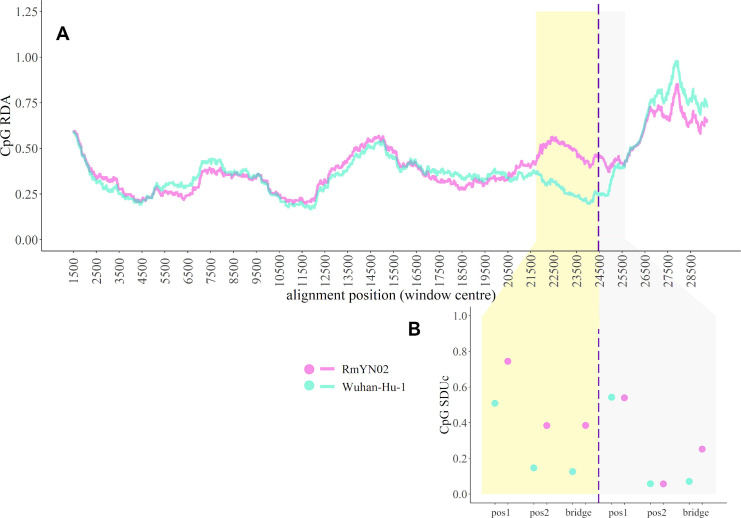
(A) 3kb sliding window plot of RDA across the whole-genome alignment of Wuhan-Hu-1 (turquoise) and RmYN02 (magenta). Shaded regions depict the Spike ORF region in the alignment. The dashed line indicates the inferred RmYN02 Spike recombination breakpoint, splitting the shaded region into non-nCoV (yellow) and nCoV (grey). (B) SDUc values calculated for each frame position of the 2 RmYN02 Spike nonrecombinant regions and the corresponding Wuhan-Hu-1 regions. The absolute differences between SDUc values of SARS-CoV-2 and RmYN02 for each frame position are significantly greater in the non-nCoV than in the nCoV region (t2.07 = 3.03, p = 0.0450; unpaired one-tailed t test with unequal variance). The list of GenBank and GISAID accessions for the Sarbecovirus sequences used are provided in S4 Table. nCoV, new coronavirus; ORF, open reading frame; RDA, relative dinucleotide abundance; SARS-CoV-2, Severe Acute Respiratory Syndrome Coronavirus 2; SDUc, corrected synonymous dinucleotide Usage.